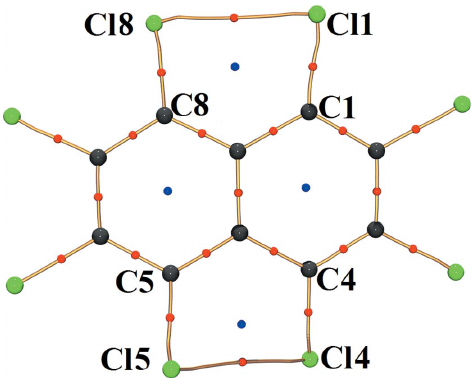
Figure 3 Molecular graph depicting experimental bond paths along with critical points of peri Cl (cid:2)(cid:2)(cid:2) Cl interactions. The blue dots represent the (3,+1) ring critical point (RCP) while the red dots represent the (3, (cid:6) 1) bond critical points (BCP). The curved segments signifies the bond paths between atoms.